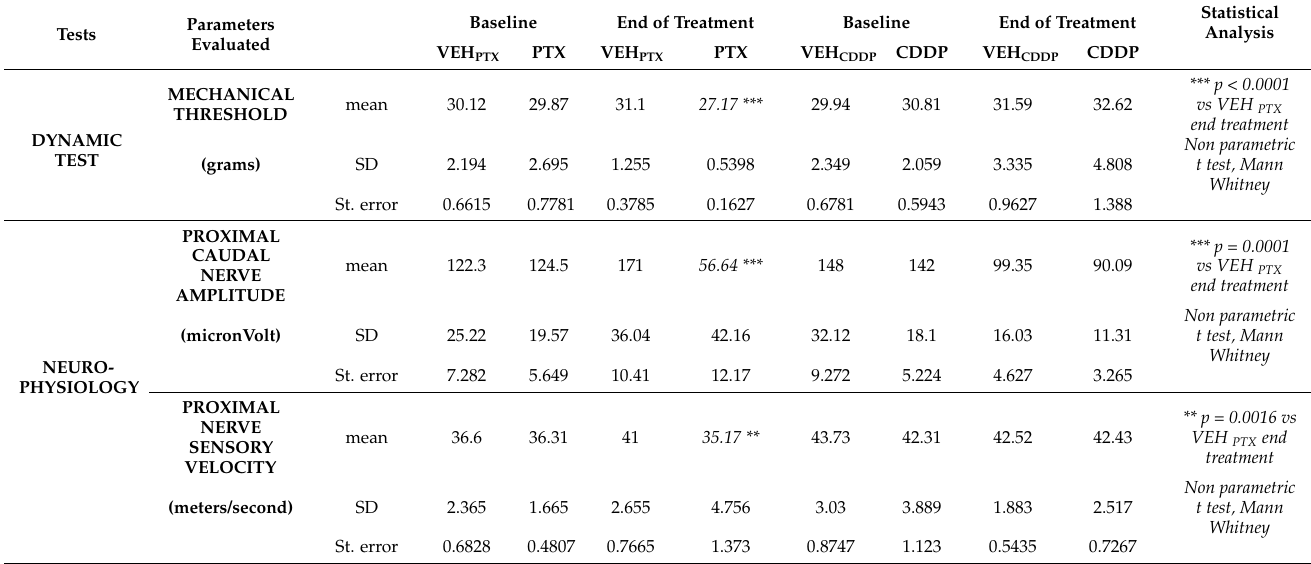
Table 2. Data recorded from the behavioral test for the mechanical threshold (dynamic test), neu- rophysiology, DRG morphometry, and IENFD (intraepidermal nerve fiber density) quantifications, at baseline and at end of treatments with vehicles and chemotherapies. Statistical analyses are also